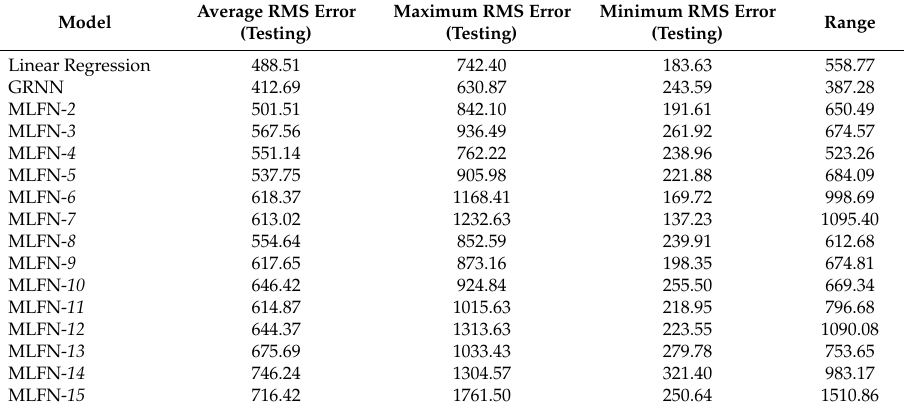
Table 2. RMS errors of different predictive models. Multilayer feedforward neural networks (MLFNs) with different numbers of hidden neurons are represented as MLFN- x , where x represents the number of hidden neurons. The average RMS error of each model was acquired from 15 repeated training and testing processes.